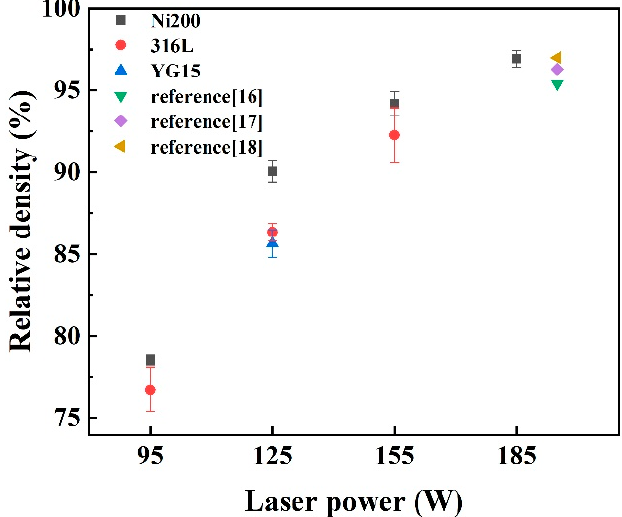
Figure 11. Relative densities of the integrated blocks.